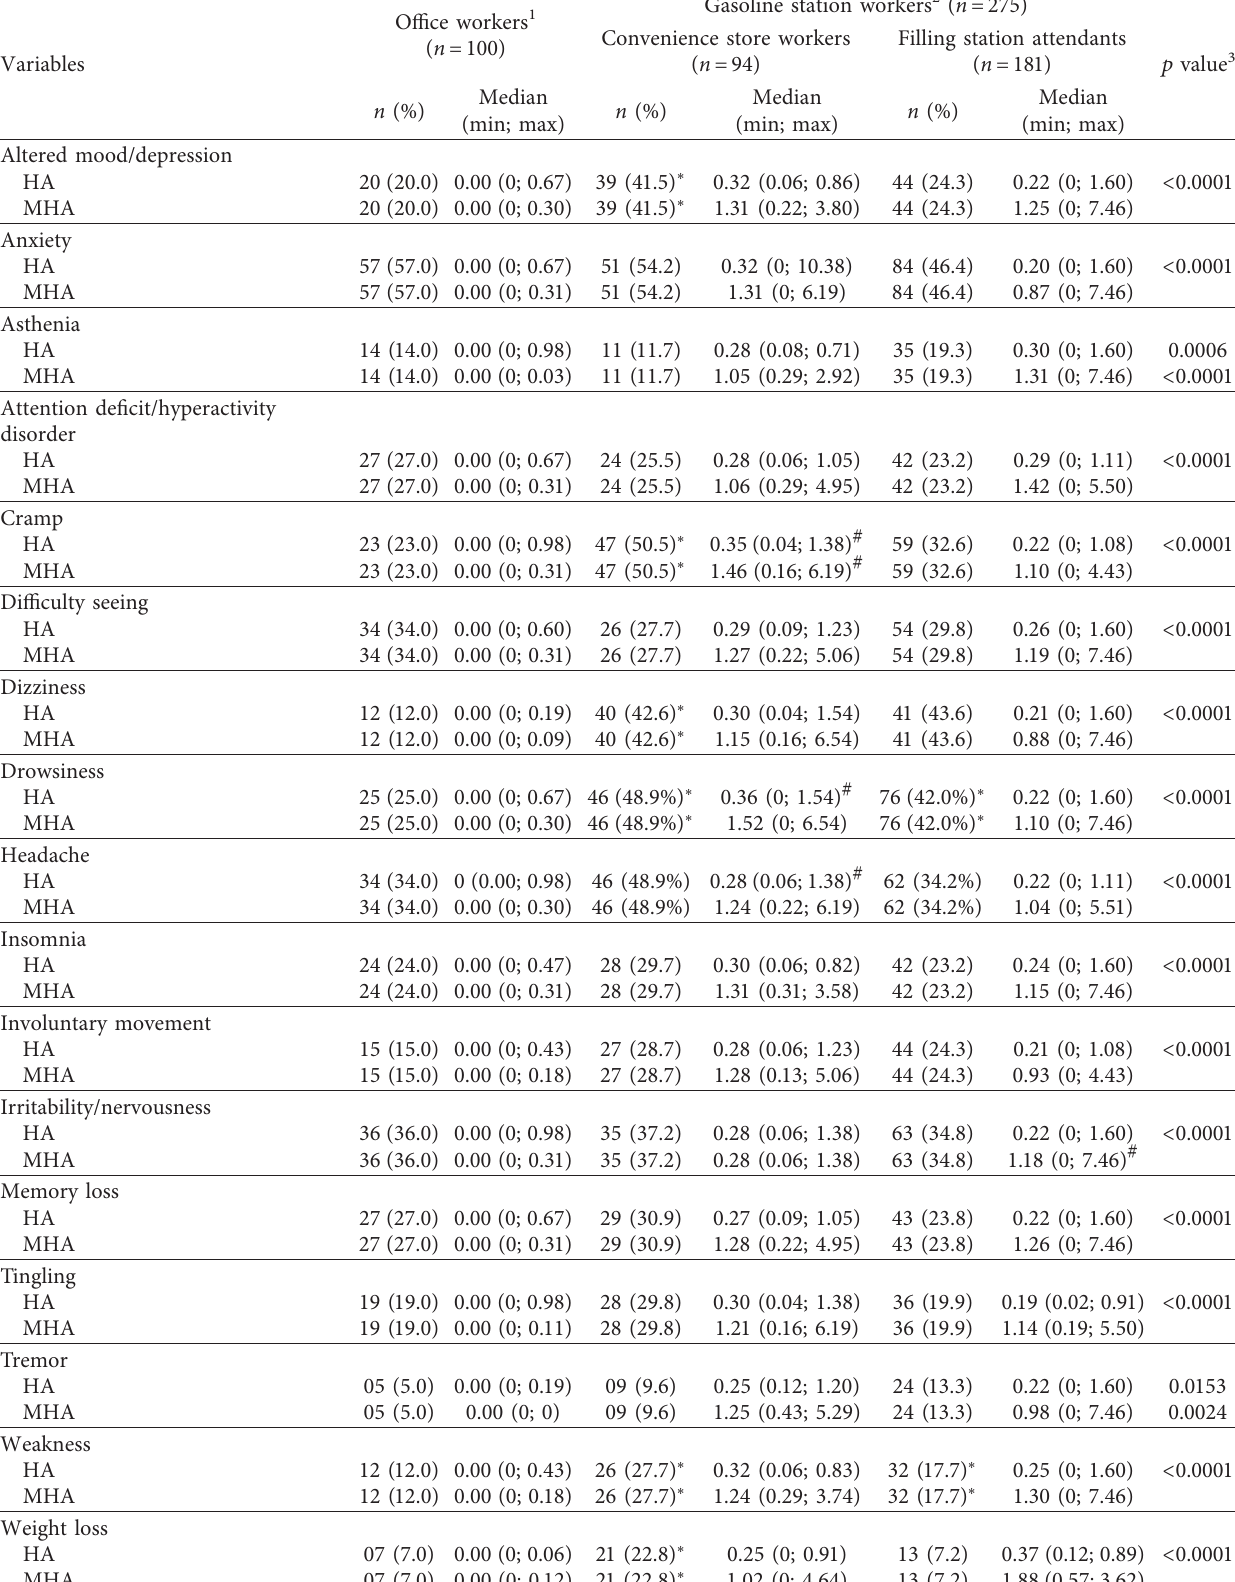
Table 3: Distribution and values of HA and MHA biomarkers on signs and symptoms of gasoline station workers (occupationally exposed to VOCs) and office workers (comparison group) in Rio de Janeiro (Brazil),